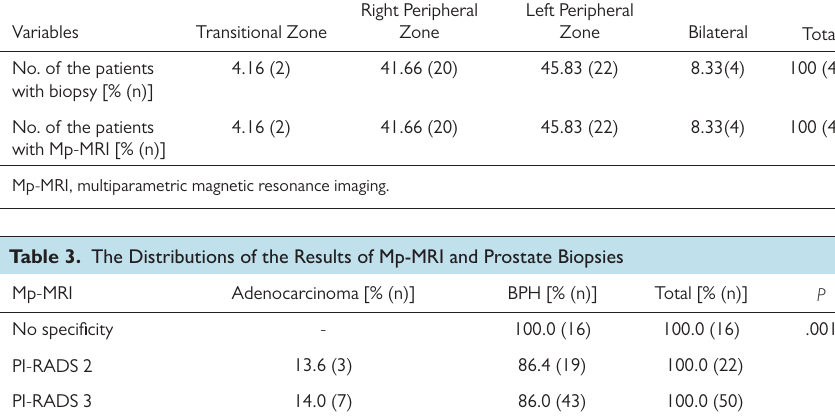
Table 2. Distribution of Mp-MRI Results of the Patients with a Result of Cancer in the Biopsy Variables